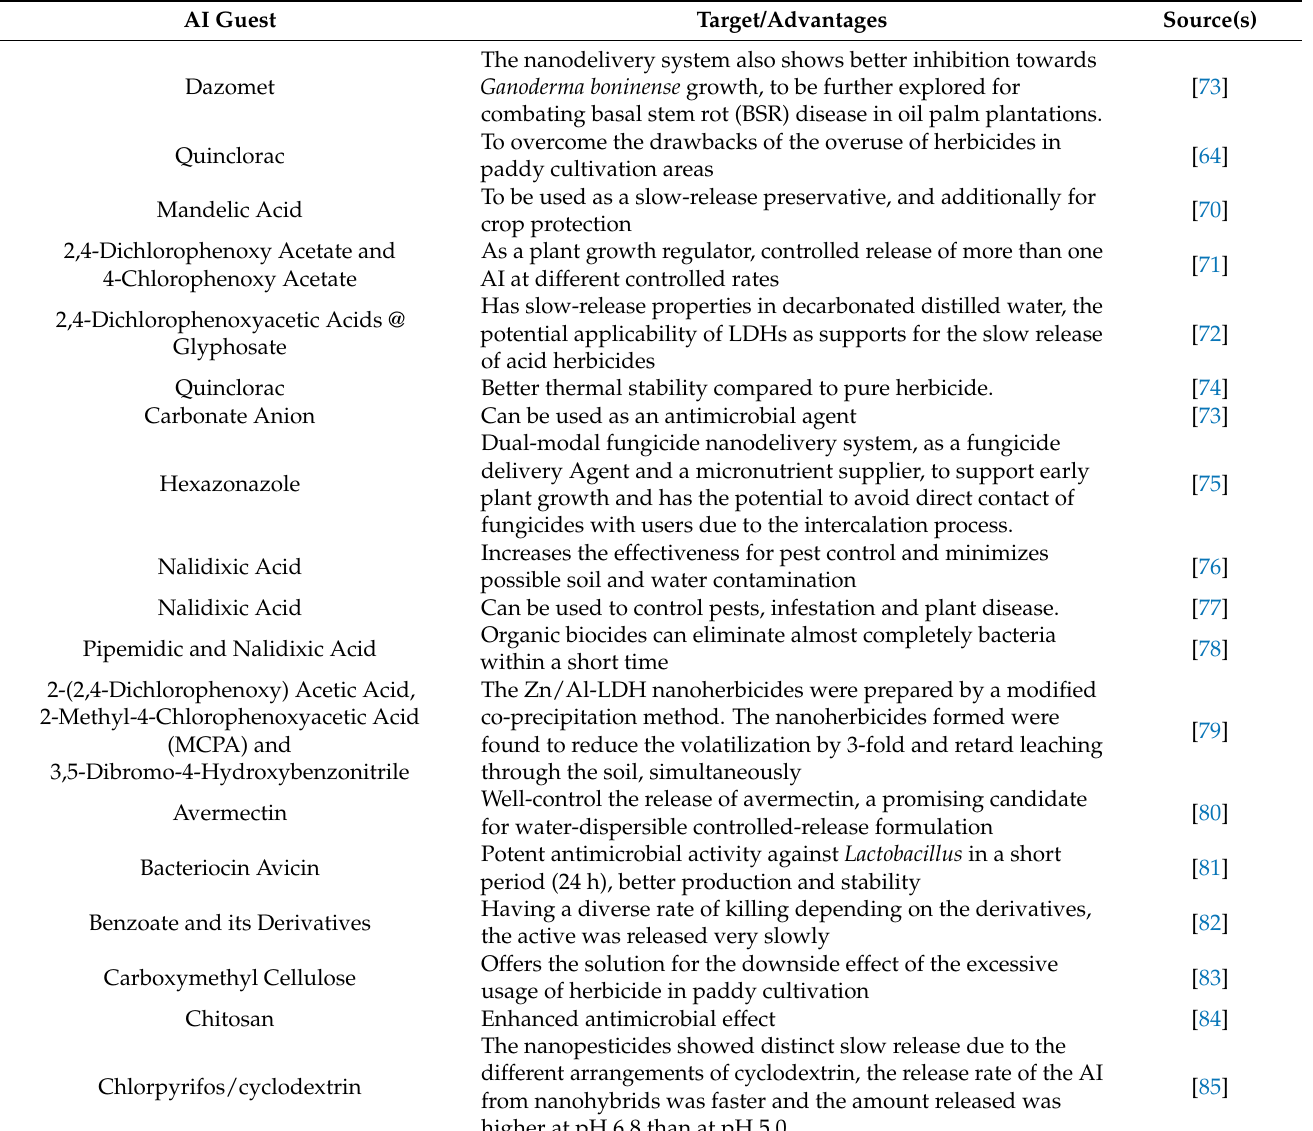
Table 5. Nanopesticides prepared using host–guest supramolecular chemistry based on a Zn/Al-LDH host using various guests, AIs, for various targets and